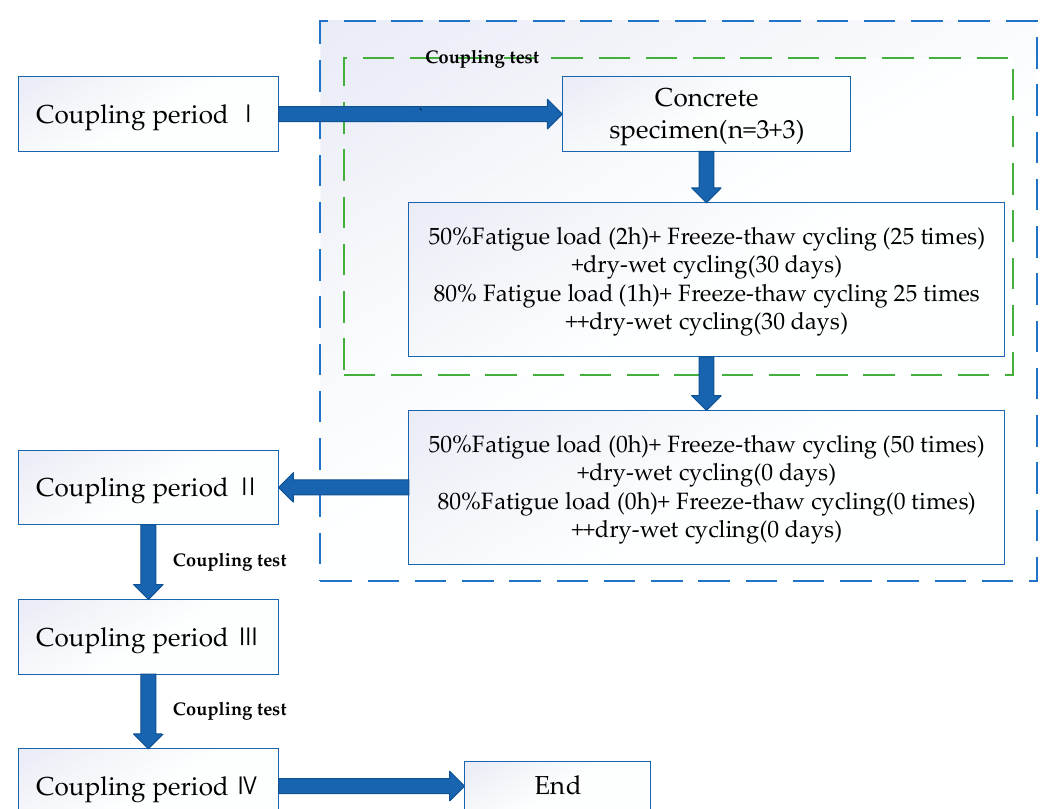
Figure 3. Flow chart of the triple ‐ field coupling experiment [30].